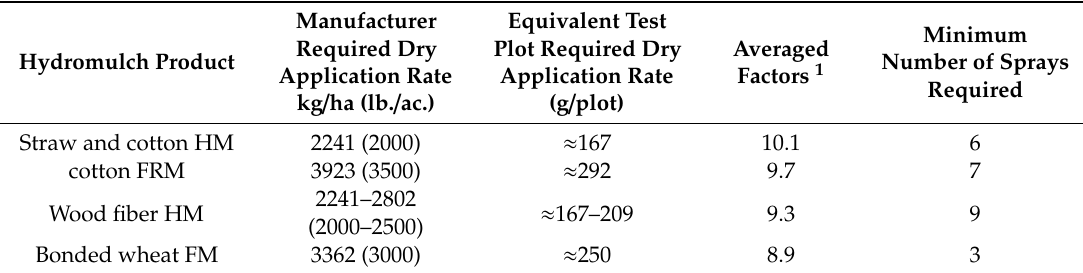
Table 3. Summary application rates for each hydromulch